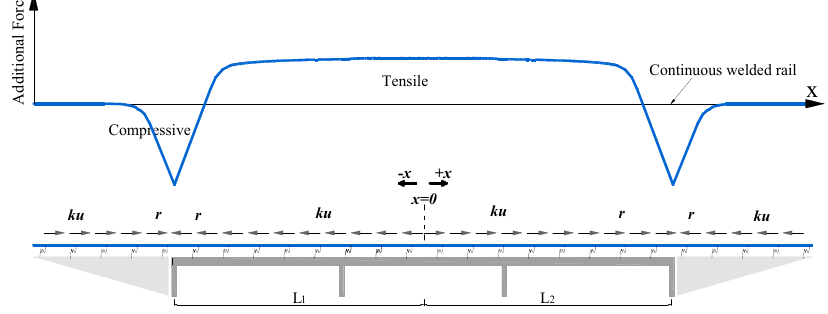
Figure 1. Basic mechanism of longitudinal additional force.